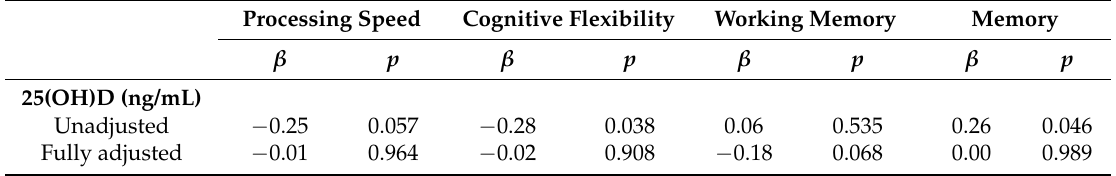
Table 5. Association of serum 25-hydroxyvitamin d with measures of cognitive function. (fully adjusted). Processing Speed Cognitive Flexibility Working